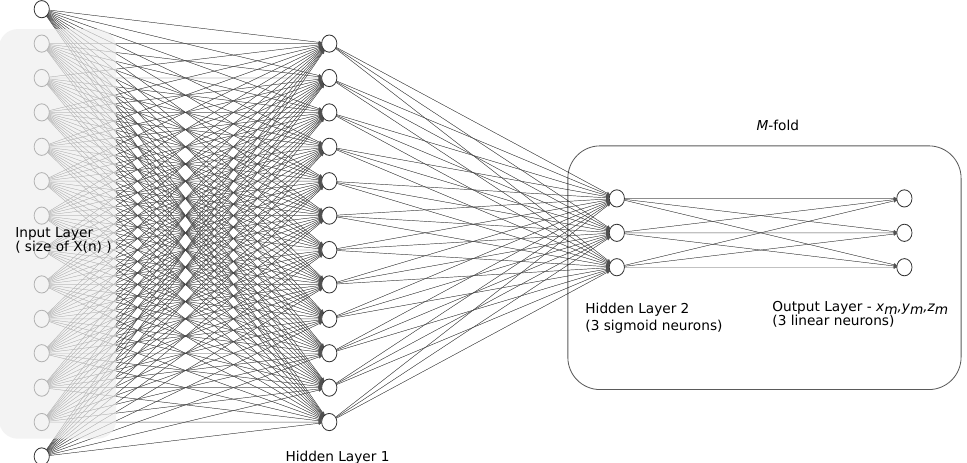
Figure 8. Architecture of the neural network used for regression.